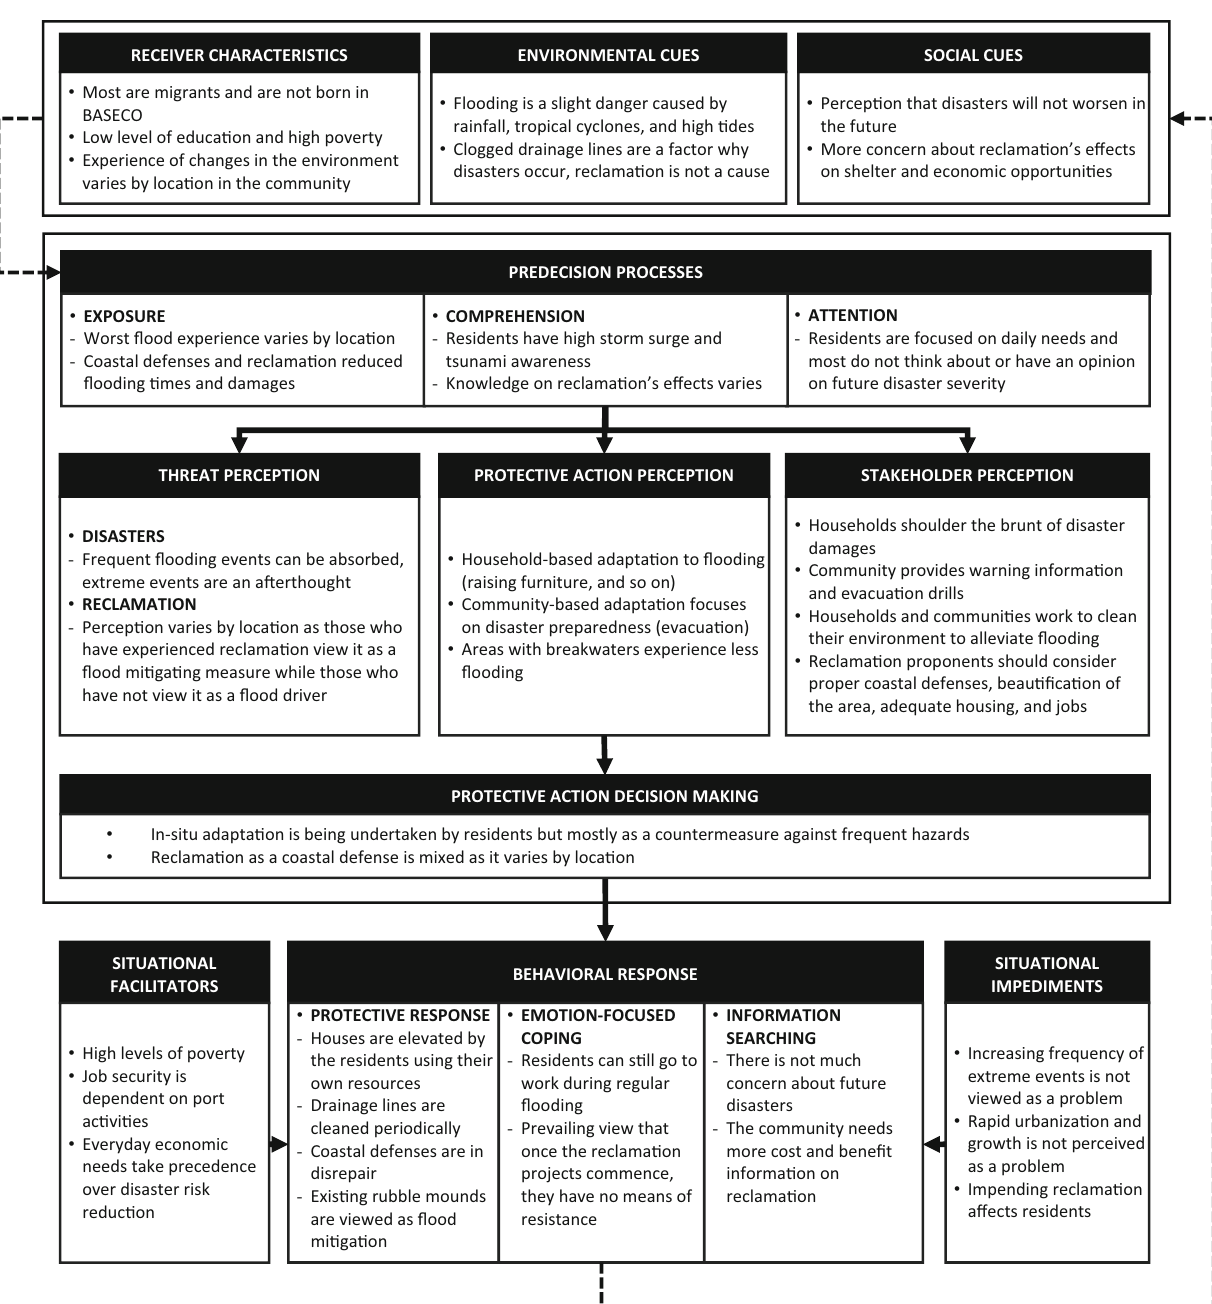
Fig. 5 The Protective Action Decision Model (PADM) for disaster perception in the BASECO Compound in